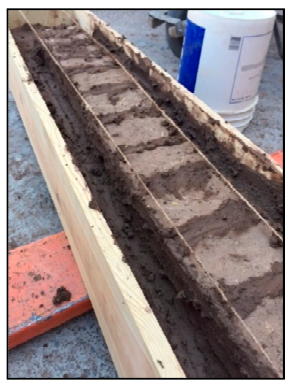
Figure 1. Construction of the wall foundation: Adobe bricks being placed in the wooden frame to form the footing.